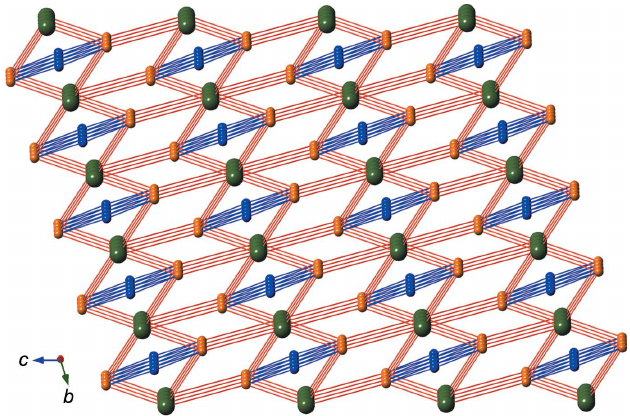
Figure 5 Schematic perspective of the 4,5,6-connected {4 2 .8 4 }{4 6 .6 6 .8 3 }{4 8 .6 2 } 2 topology network of the [Na 2 (H 2 O) 4 Cu(btcH) 2 ] n three-dimensional coordination polymer within the title compound. The 4-connected Cu II atom nodes are depicted as blue spheres. The 5-connected btcH ligand nodes are depicted as orange spheres. The 6-connected Na 2 ( (cid:2) -H 2 O) 22+ cluster modes are depicted as green spheres.